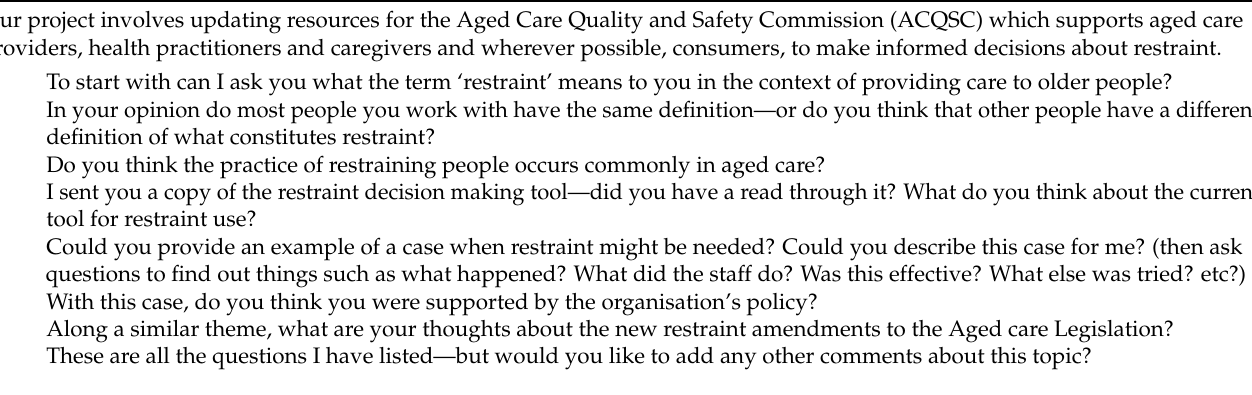
Table 1. Semi-structured interview